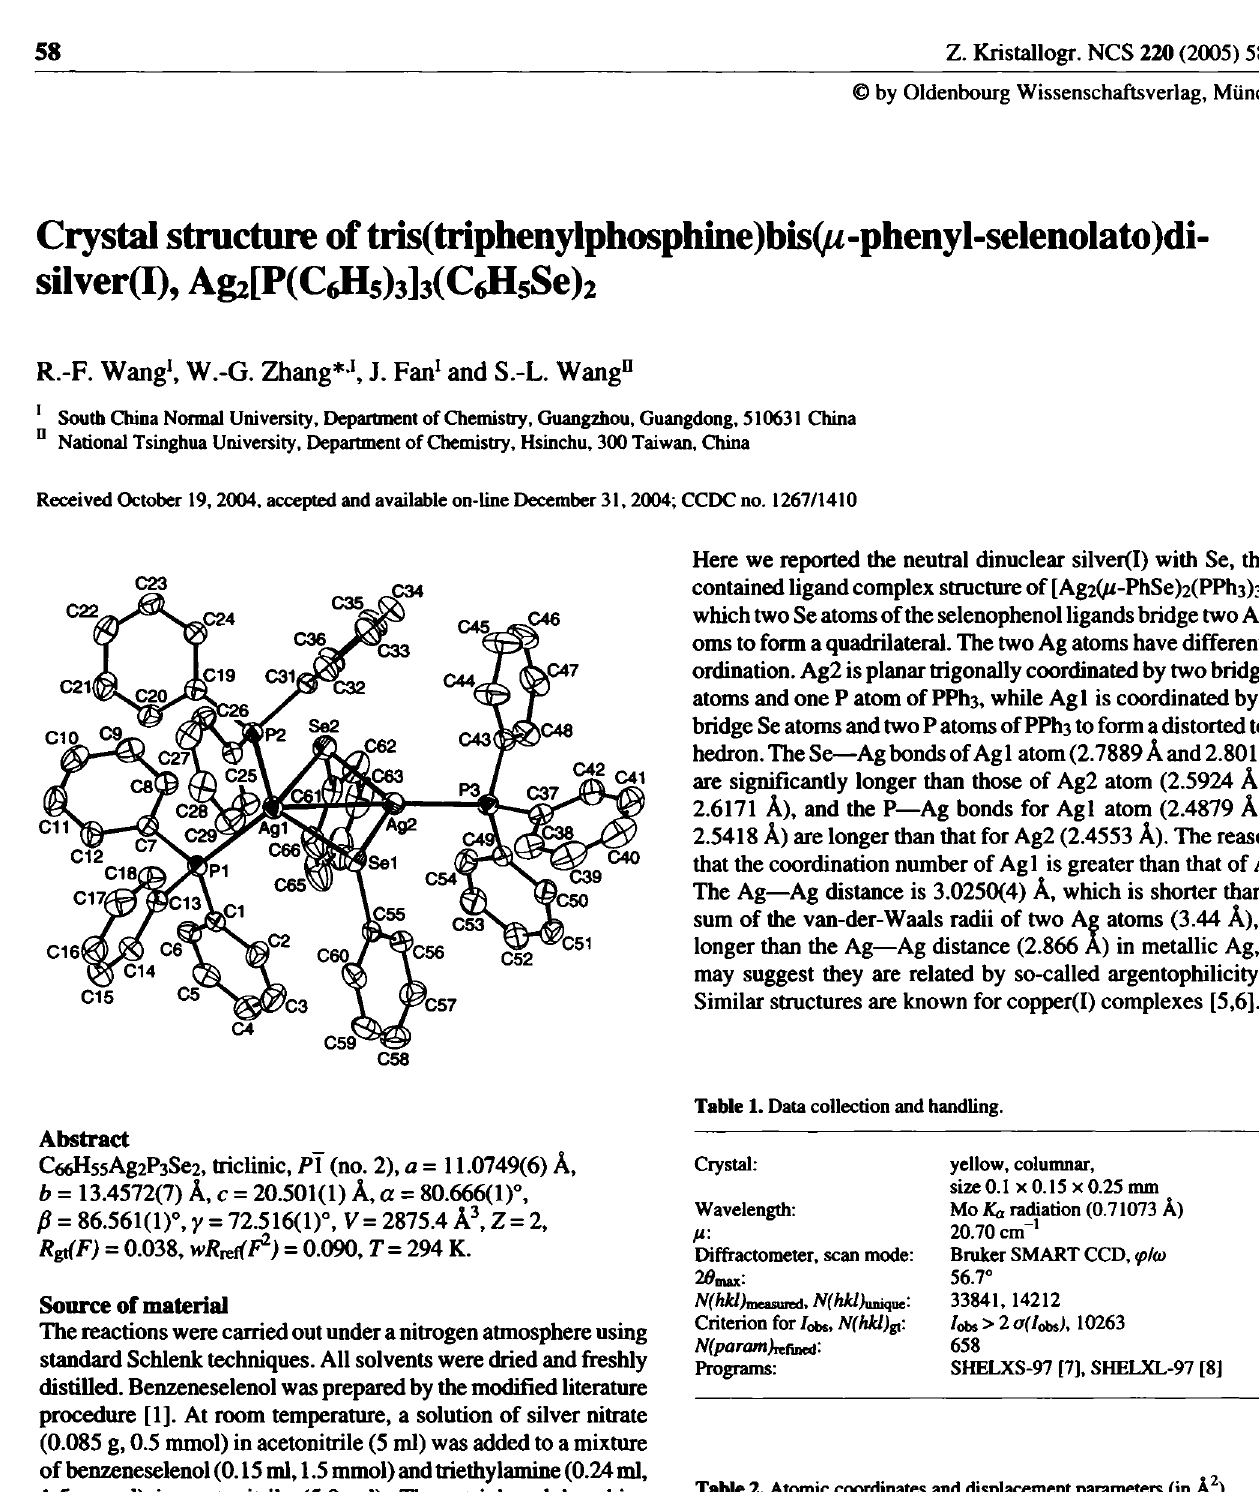
Table 2. Atomic coordinates and displacement parameters (in Ä 2